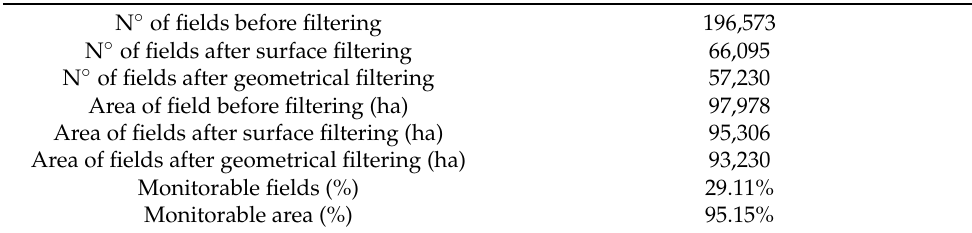
Table 4. Number and surface of monitorable